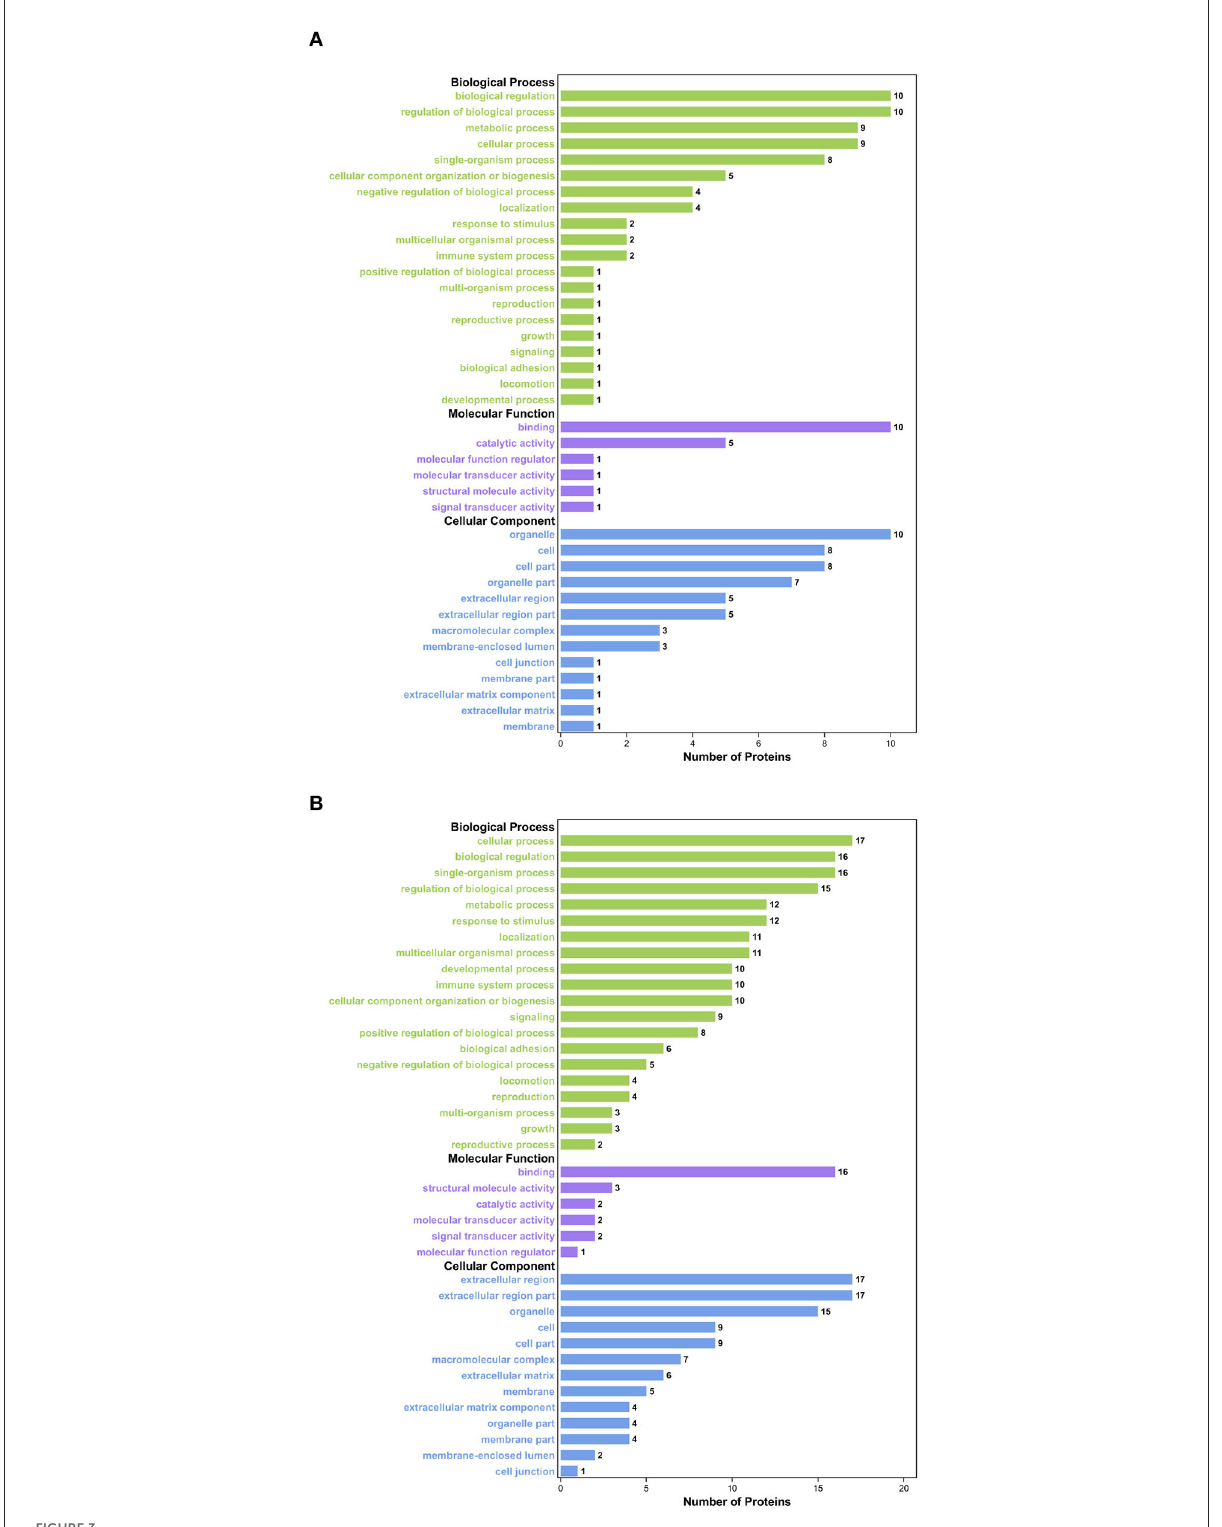
FIGURE3 GO enrichment analysis of the significantly differential proteins between DHD calves and clinically healthy calves. (A) GO enrichment analysis on the ontology of molecular function, cellular component, and biological process of the significantly increased proteins. (B) GO enrichment analysis of the significantly decreased